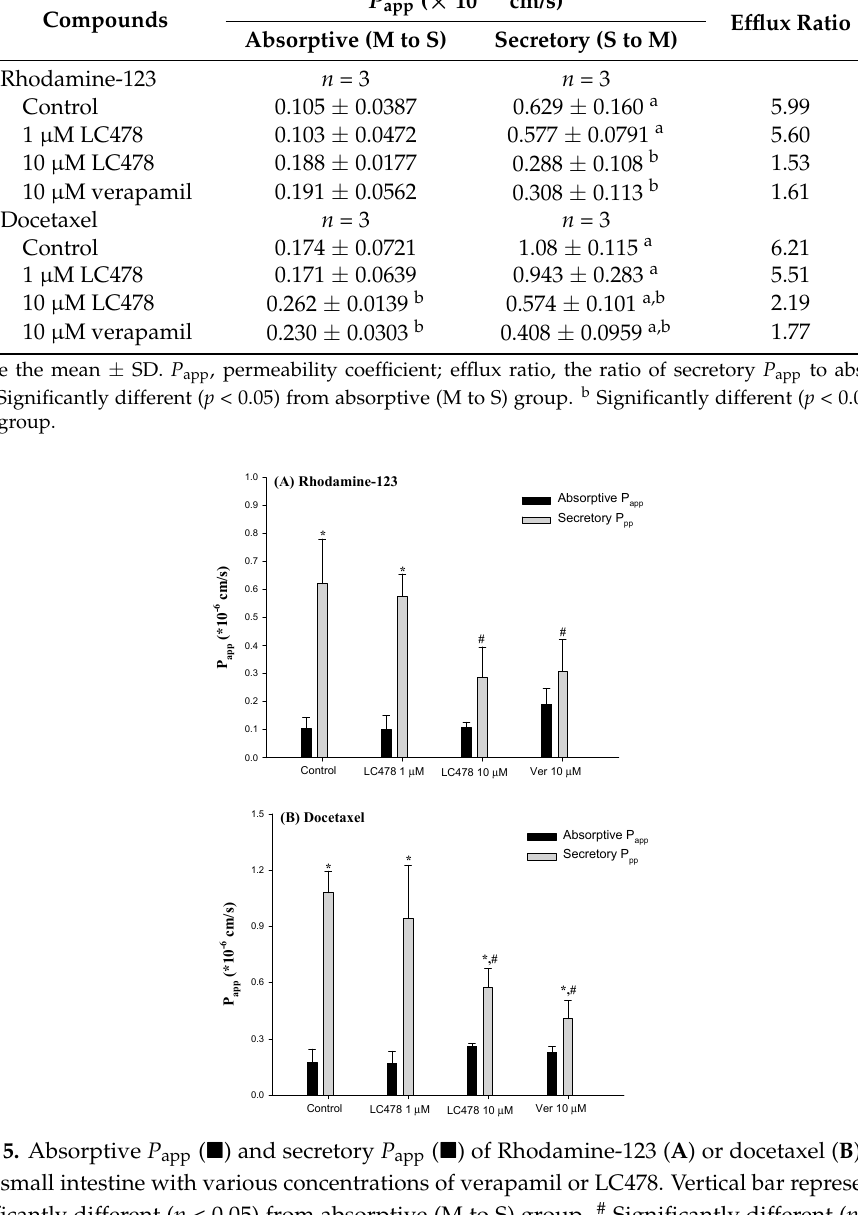
Table 3. Absorptive P app , secretory P app , efflux ratio of rhodamine-123 or docetaxel across the small intestine with various concentrations of LC478 or verapamil.